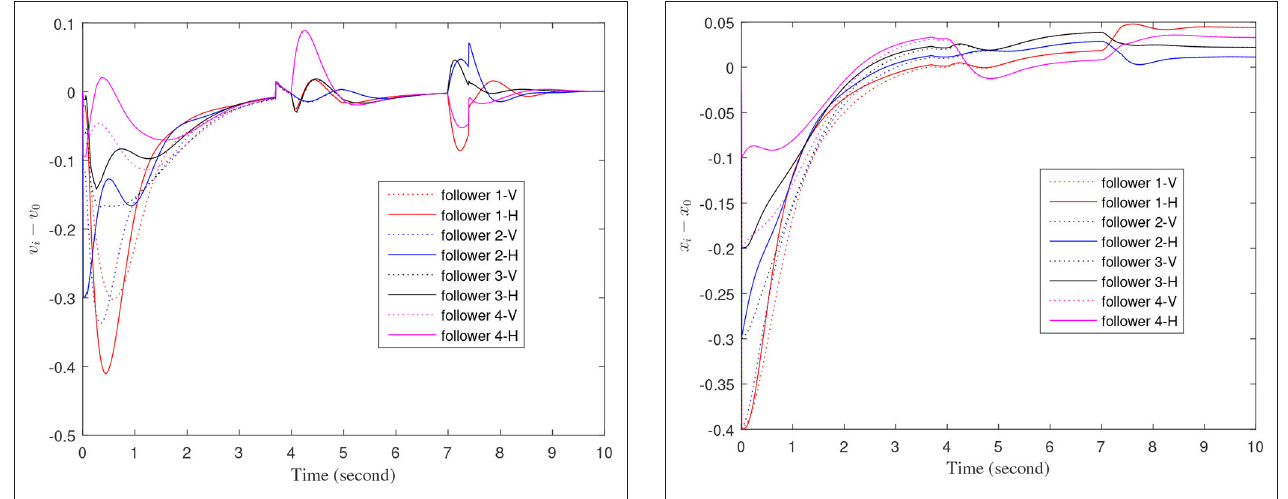
FIGURE 8 | The velocity error between the follower car and the leader car. FIGURE 9 | The real-time distance between each follower car and the leader